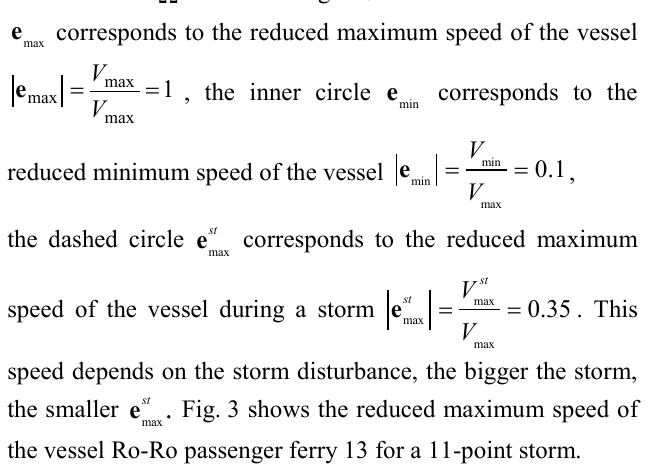
the dashed circle